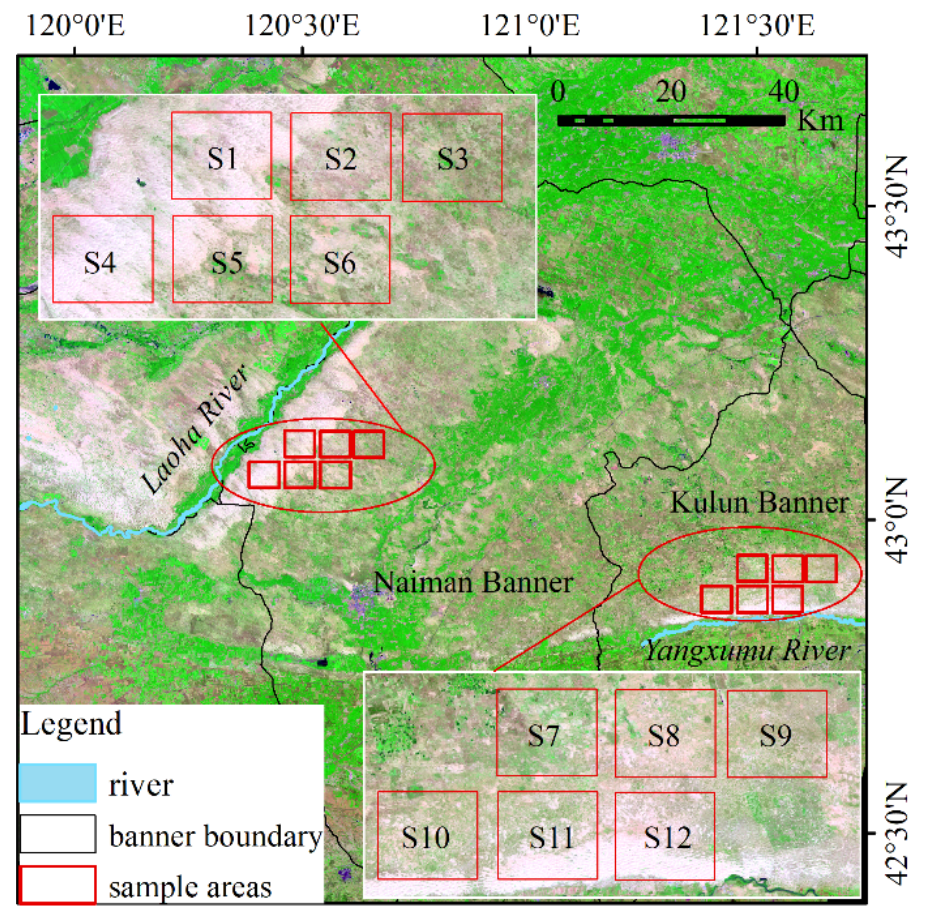
Figure 1. Location of the study area.